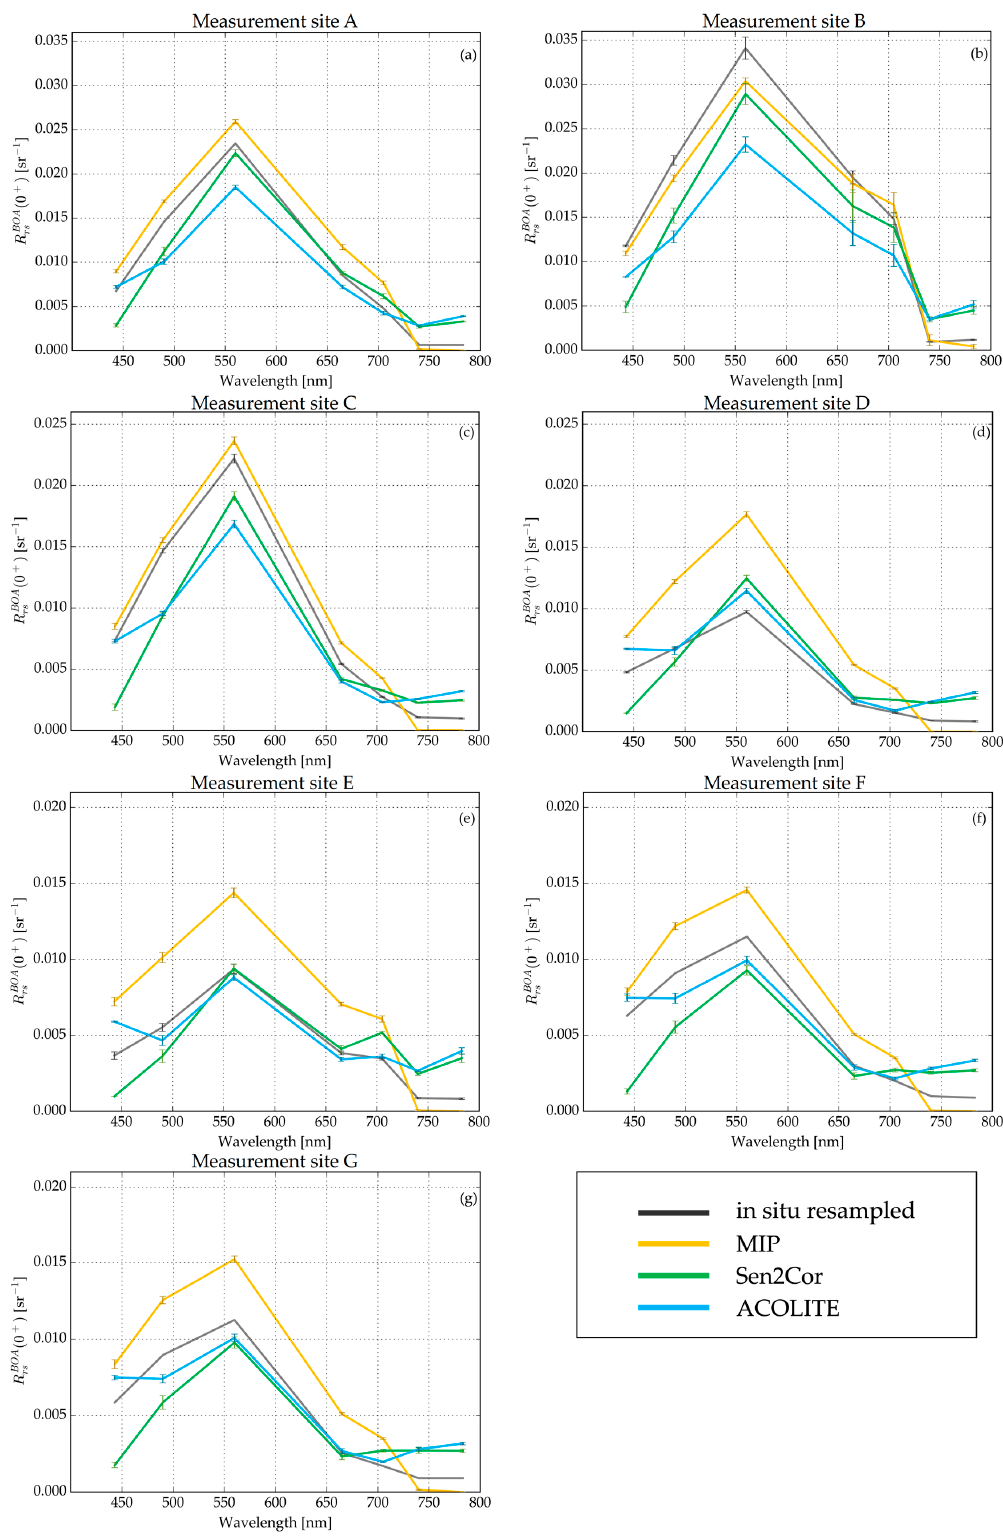
(cid:0) (cid:1) 0 + , λ